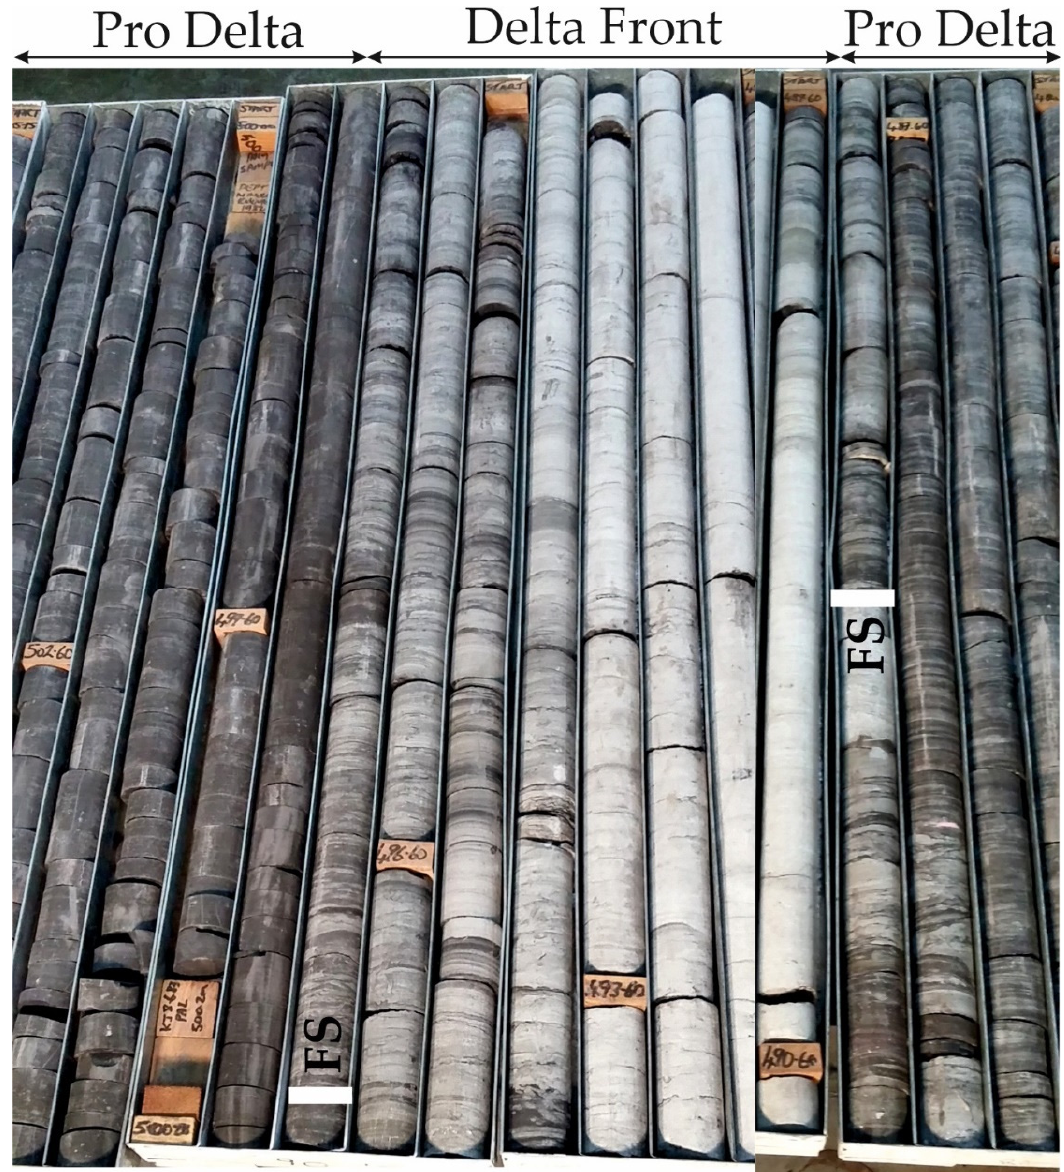
Figure 11. Core photographs illustrating the change from prodelta to delta-front deposits displaying smaller-scale coarsening and thickening upward cycles. The cycle is bounded by a surface that marks water deepening, from delta-front or delta-plain to overlying prodelta. The surface corresponds to flooding surface (FS), developed during periods of transgression.